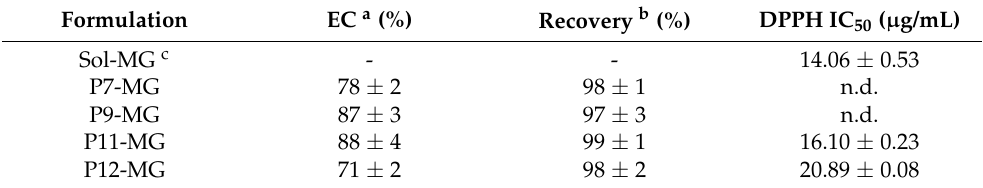
Table 4. MG entrapment and DPPH radical-scavenging capacity of the indicated formulations.